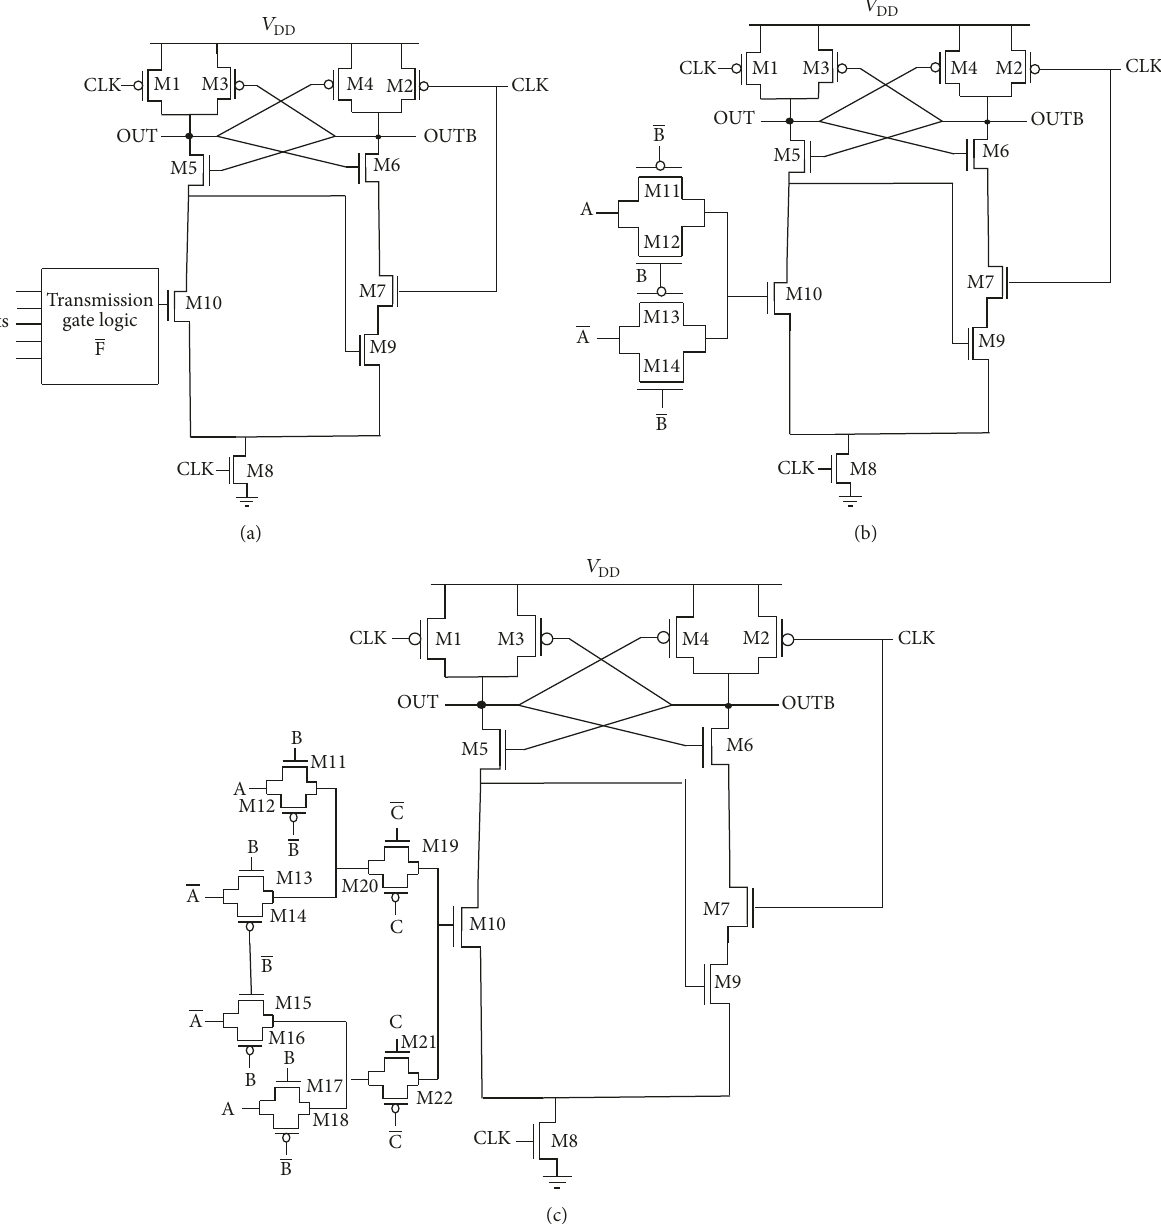
Figure 4: (a) Proposed architecture-1 for TG-EDCVSL circuits. (b) Two-input and (c) three-input TG-EDCVSL XOR-XNOR